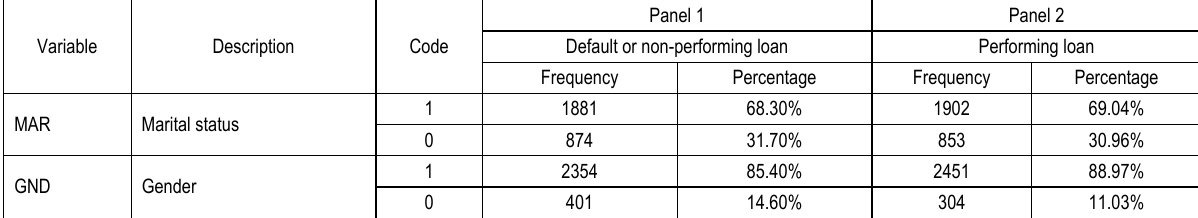
Table 3 (cont.). Descriptive statistics of the credit risk variables